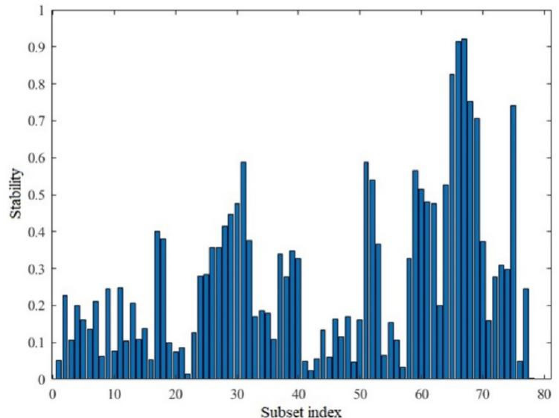
Figure 6. Stability diagram of spectral bands selected by MCUVE.